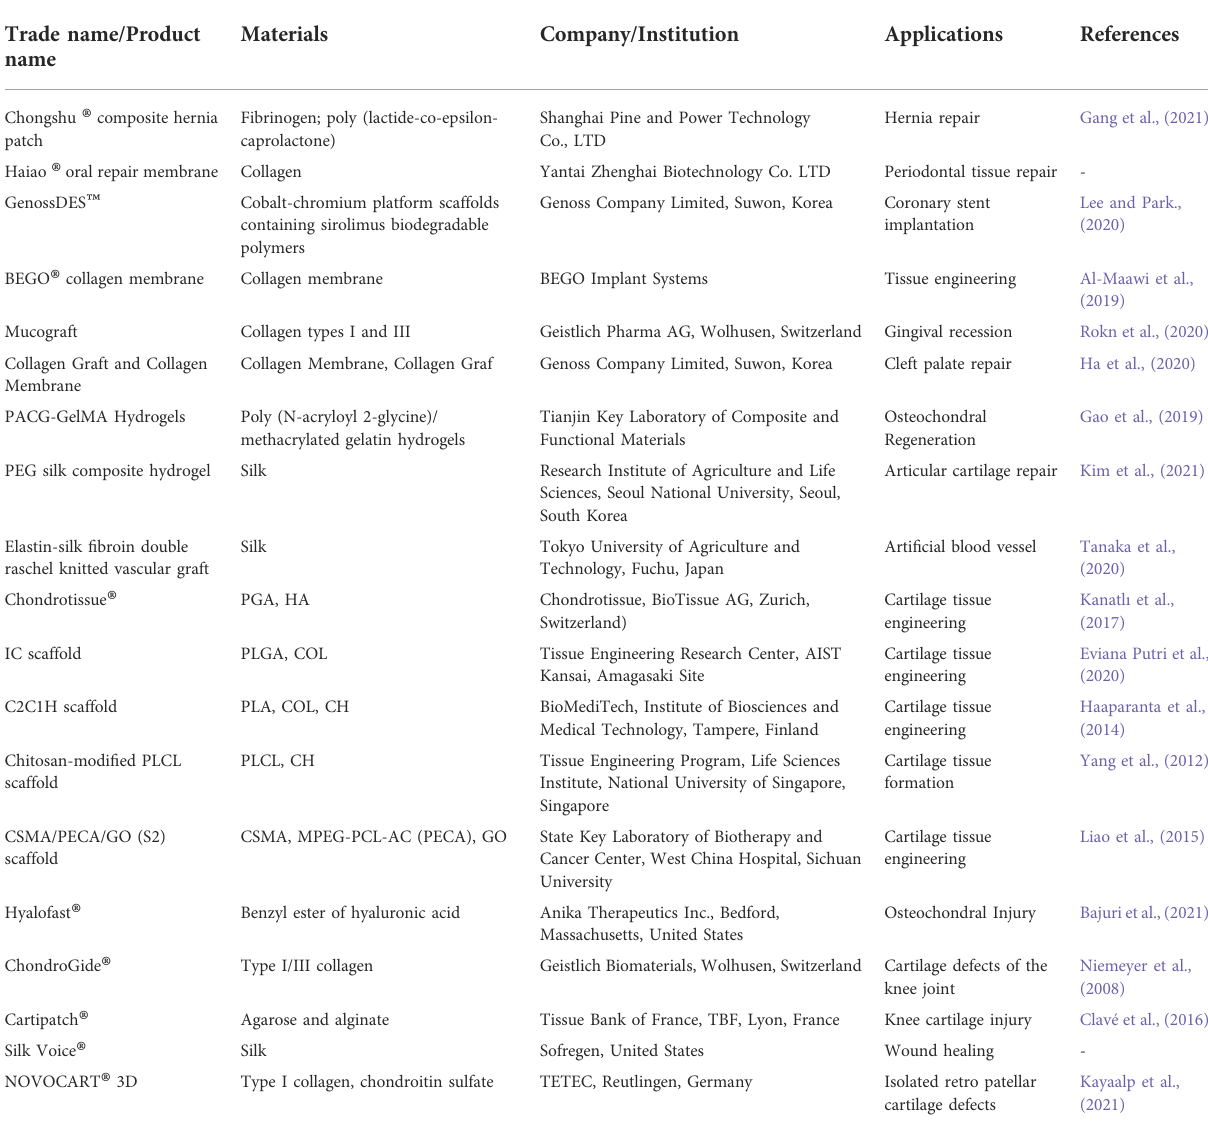
TABLE 1 Status of natural polymer-based scaffolds in clinical